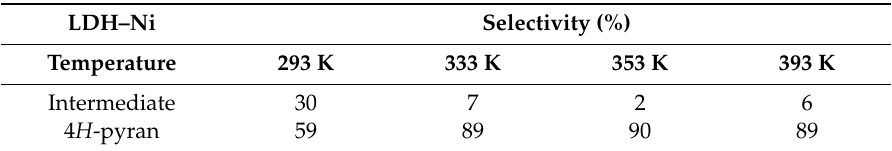
Table 5. E ff ect of temperature on the 4 H -pyran